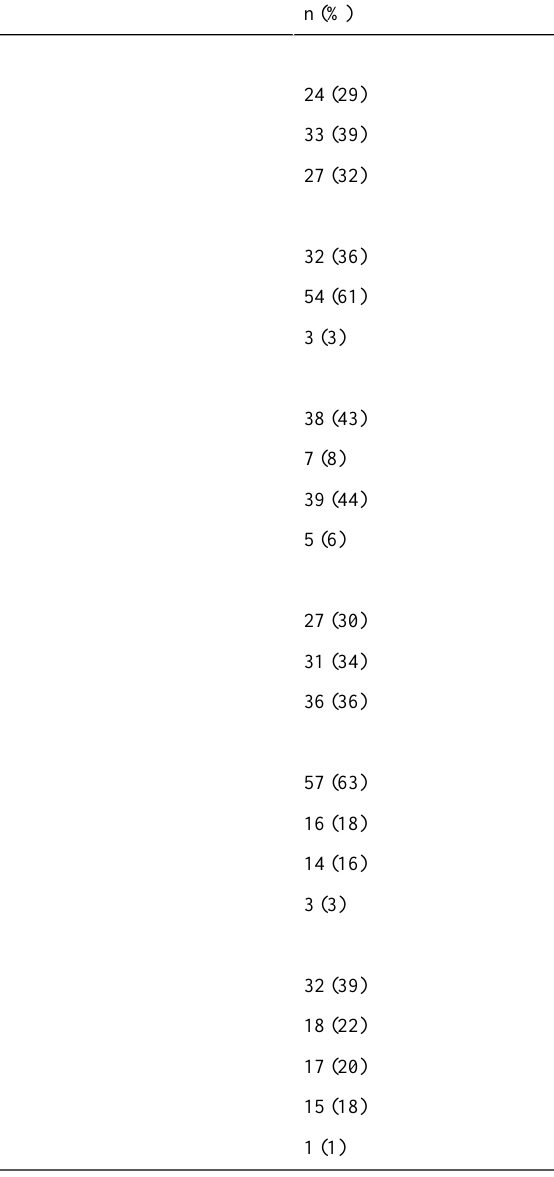
Table 1. Demographic